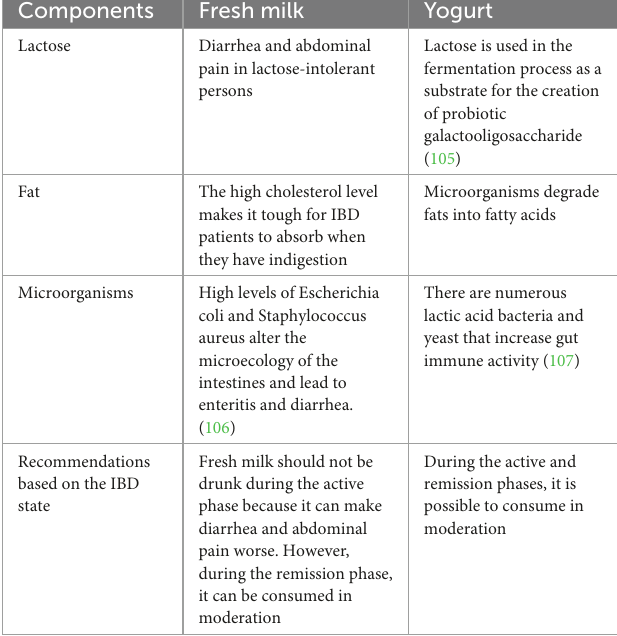
TABLE 1 Composition of fresh milk and yogurt, effects on symptoms, and the corresponding consumption recommendations for IBD patients.